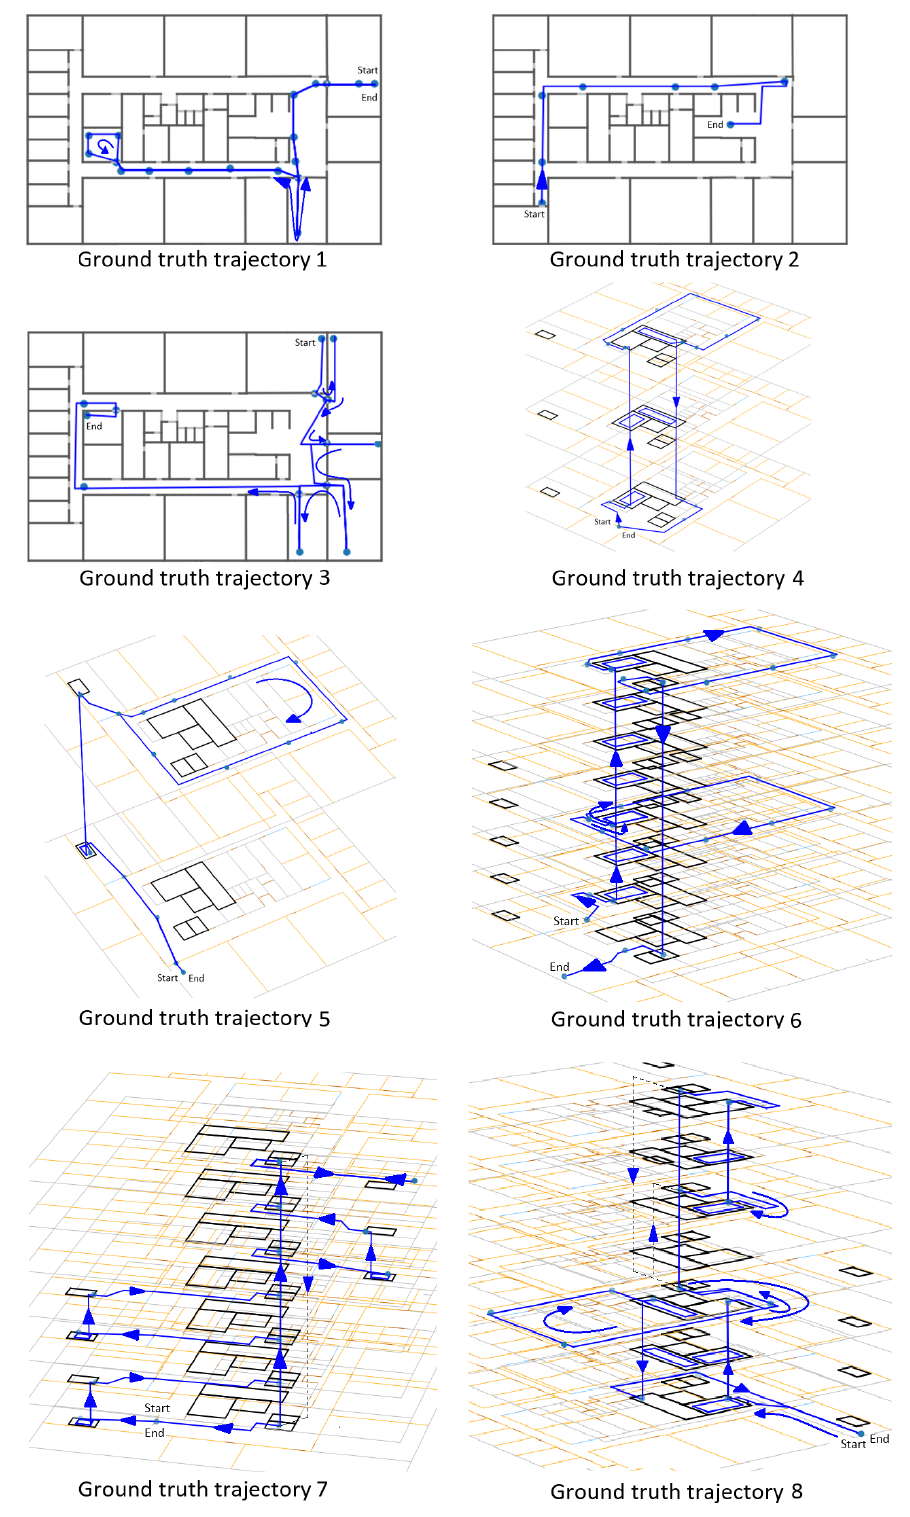
Figure 8. Evaluation trajectories: dots are the known positions used for evaluation. The first three trajectories are on the fifth floor only. The other trajectories are multifloor trajectories. The total length of all trajectories is 1.2